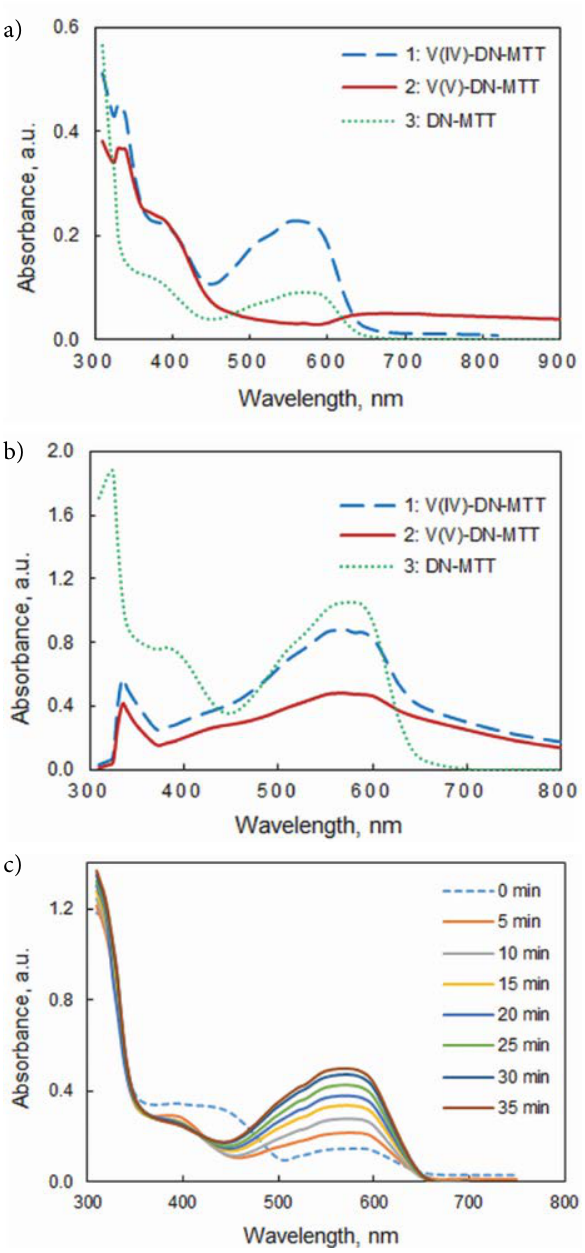
Figure 1. Absorption spectra in chloroform. a ) At a low DN con- centration, 8 × 10 −5 mol dm −3 : 1 – V IV -DN-MTT against blank; 2 – V V -DN-MTT against blank; 3 – blank (DN-MTT) against chloro- form. c V(IV) = c V(V) = 3 × 10 −5 mol dm −3 , c MTT = 1.5 × 10 −4 mol dm −3 , pH 5, extraction time 2 min. b ) At a high DN concentration, 1.6 × 10 −3 mol dm −3 : 1 – V IV -DN-MTT against blank; 2 – V V -DN-MTT against blank; 3 – blank (DN-MTT) against chloroform. c V(IV) = c V(V) = 3 × 10 −5 mol dm −3 , c MTT = 2.4 × 10 −4 mol dm −3 , pH 5, extrac- tion time 2 min. c ) Influence of time on the spectrum of the blank: c DN = 4 × 10 −4 mol dm −3 , c MTT = 1.0 × 10 −4 mol dm −3 , pH 5, extrac- tion time 2